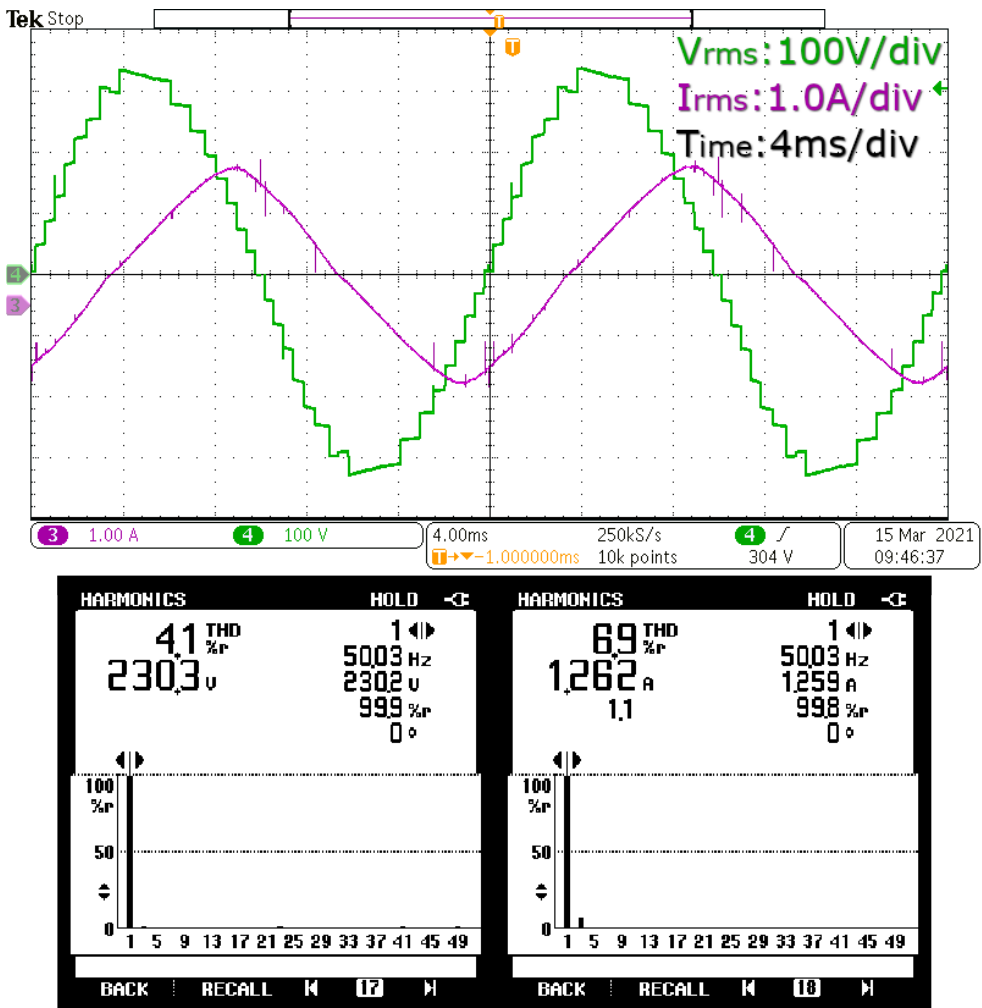
Figure 17. Experimental output waveforms and THD analysis under incandescent light bulb load.